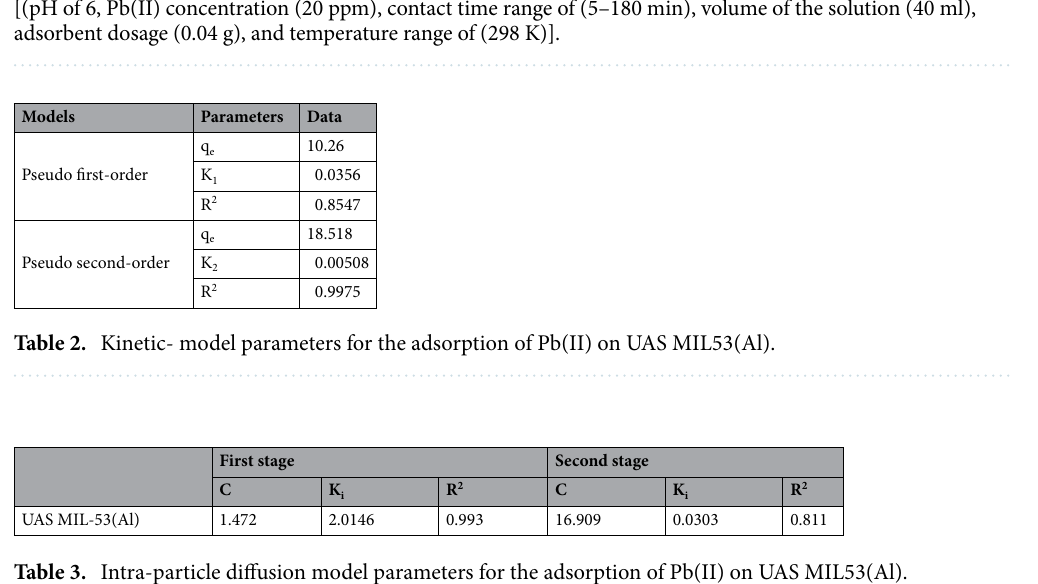
Table 3. Intra-particle diffusion model parameters for the adsorption of Pb(II) on UAS